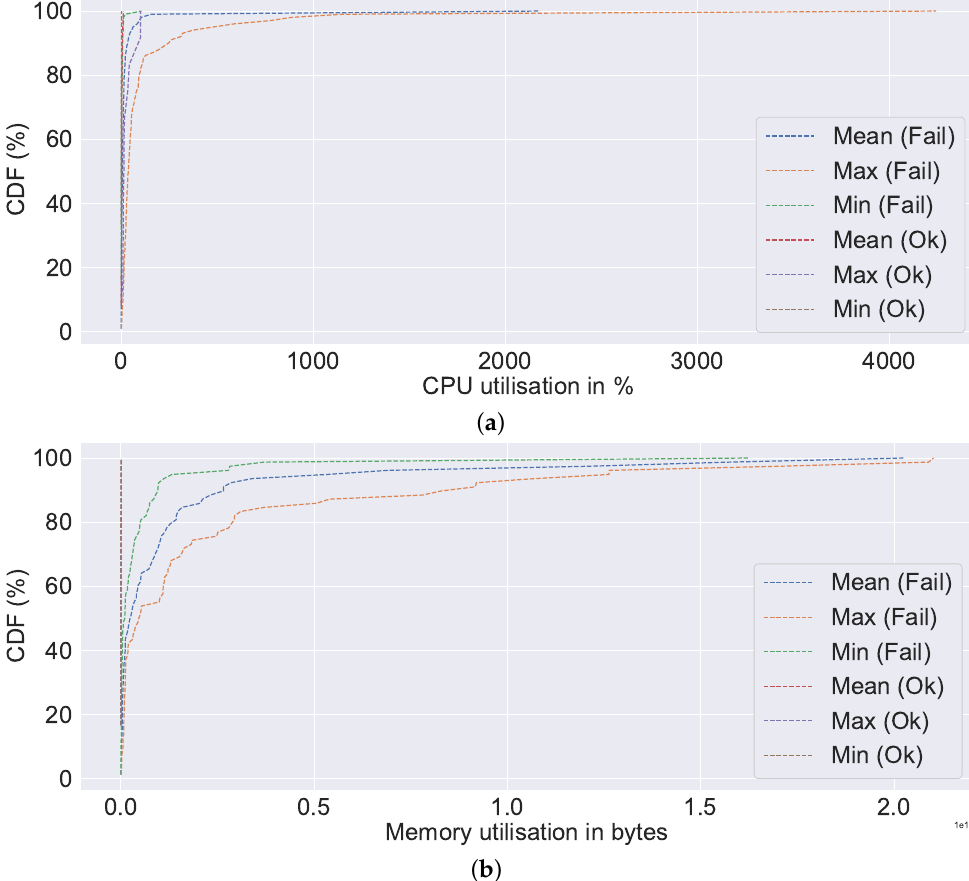
Figure 12. Visualisation of the CDF of CPU and memory utilisation. ( a ) CDF of CPU utilisation; ( b ) CDF of memory